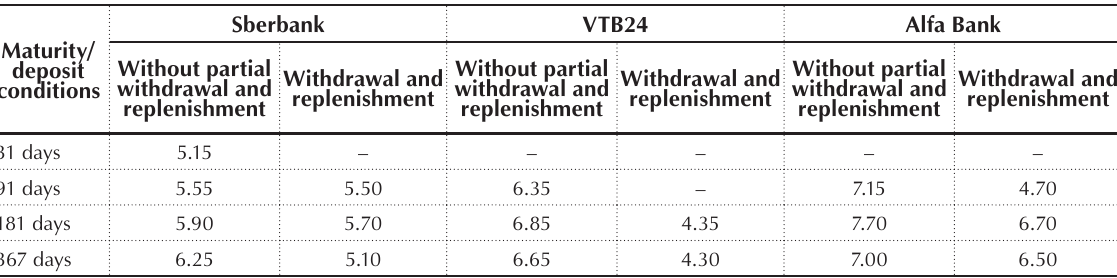
Table 6. (cid:100)(cid:346)(cid:286)(cid:3)(cid:346)(cid:381)(cid:437)(cid:400)(cid:286)(cid:346)(cid:381)(cid:367)(cid:282)(cid:3)(cid:410)(cid:286)(cid:396)(cid:373)(cid:3)(cid:282)(cid:286)(cid:393)(cid:381)(cid:400)(cid:349)(cid:410)(cid:400)(cid:3)(cid:272)(cid:381)(cid:374)(cid:282)(cid:349)(cid:415)(cid:381)(cid:374)(cid:400)(cid:3)(cid:381)(cid:296)(cid:3)(cid:367)(cid:286)(cid:258)(cid:282)(cid:349)(cid:374)(cid:336)(cid:3)(cid:271)(cid:258)(cid:374)(cid:364)(cid:400)(cid:3)(cid:296)(cid:381)(cid:396)(cid:3)(cid:282)(cid:286)(cid:393)(cid:381)(cid:400)(cid:349)(cid:410)(cid:3)(cid:381)(cid:296)(cid:3)(cid:1006)(cid:1009)(cid:1004)(cid:853)(cid:1004)(cid:1004)(cid:1004)(cid:3)(cid:396)(cid:437)(cid:271)(cid:856)(cid:3)(cid:258)(cid:400)(cid:3)(cid:381)(cid:296)(cid:3) (cid:94)(cid:286)(cid:393)(cid:410)(cid:286)(cid:373)(cid:271)(cid:286)(cid:396)(cid:3)(cid:1005)(cid:1004)(cid:853)(cid:3)(cid:1006)(cid:1004)(cid:1005)(cid:1010)(cid:853)(cid:3)(cid:1081)